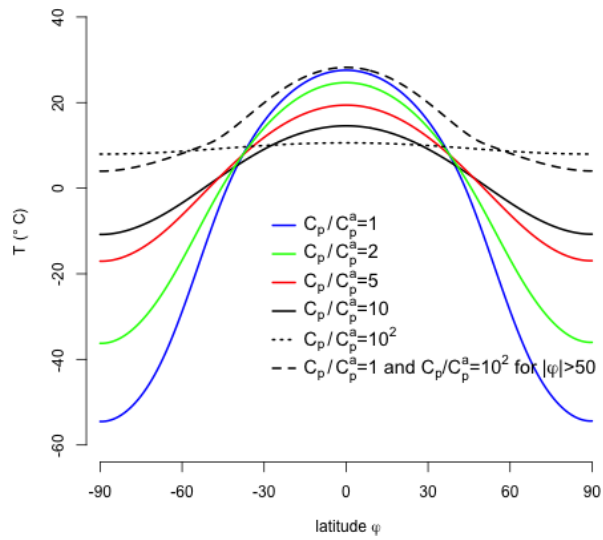
Figure 7. Annual mean temperature depending on C p when solving the seasonal resolved EBM (Eq. 17) numerically. For all solutions, we use k = 1 . 5 × 10 6 m 2 s − 11 , present-day orbital parameters and the ice–albedo feedback using the representation of Sellers (1969).